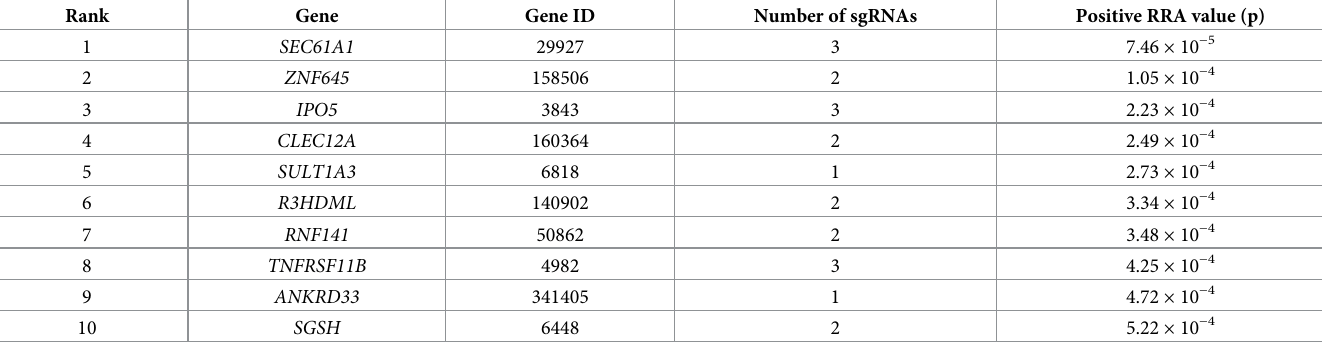
Summary of the top 10 ranking candidate genes identified by MAGeCK screening. Each Gene ID was provided by the NCBI database. “Number of sgRNAs” refers to the number of significantly enriched sgRNAs corresponding to each target gene.